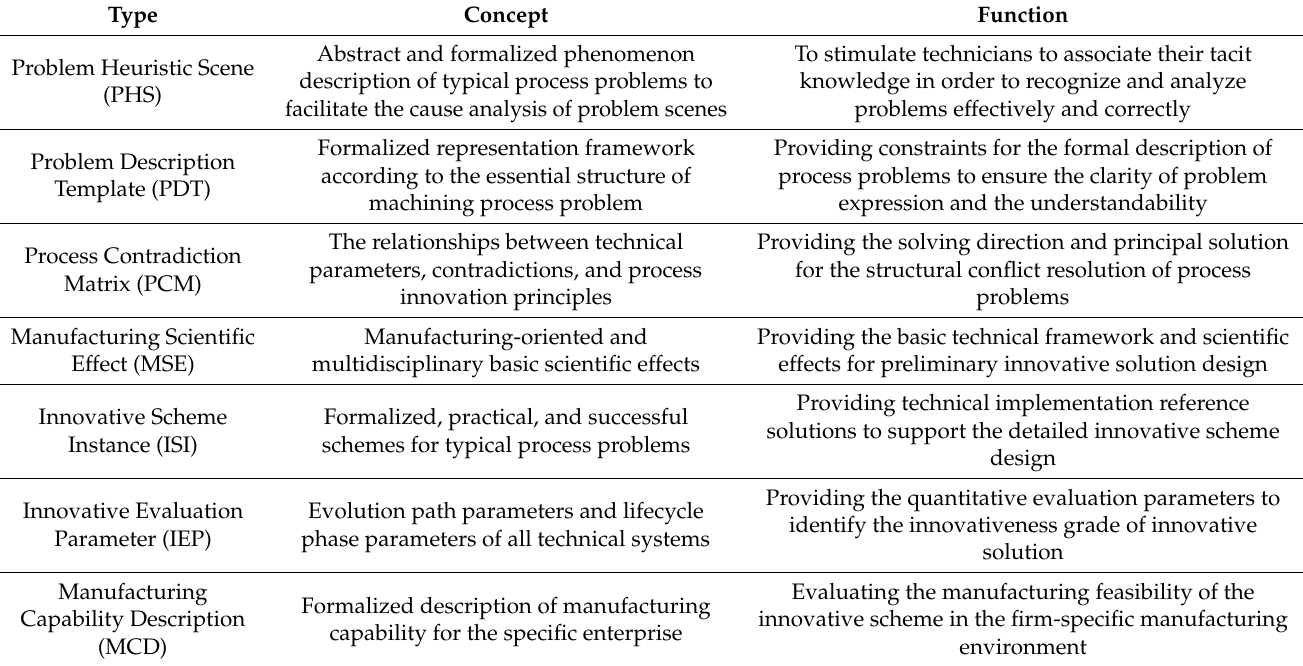
Table 1. Concept and function of each type of